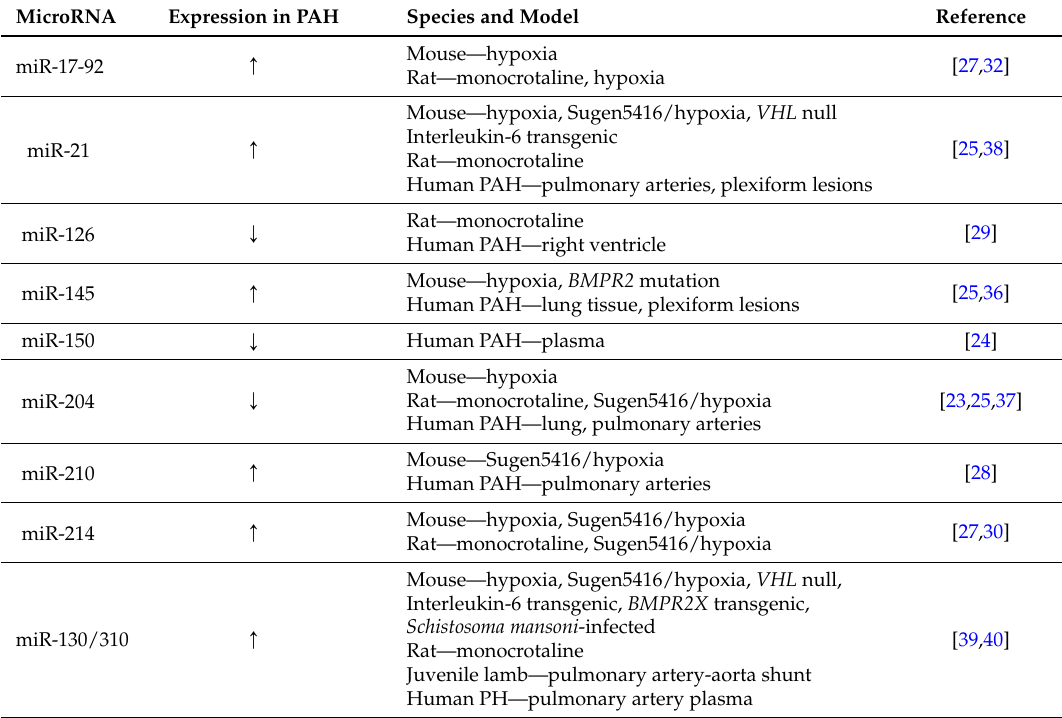
Table 2. MicroRNA expression in pulmonary arterial hypertension